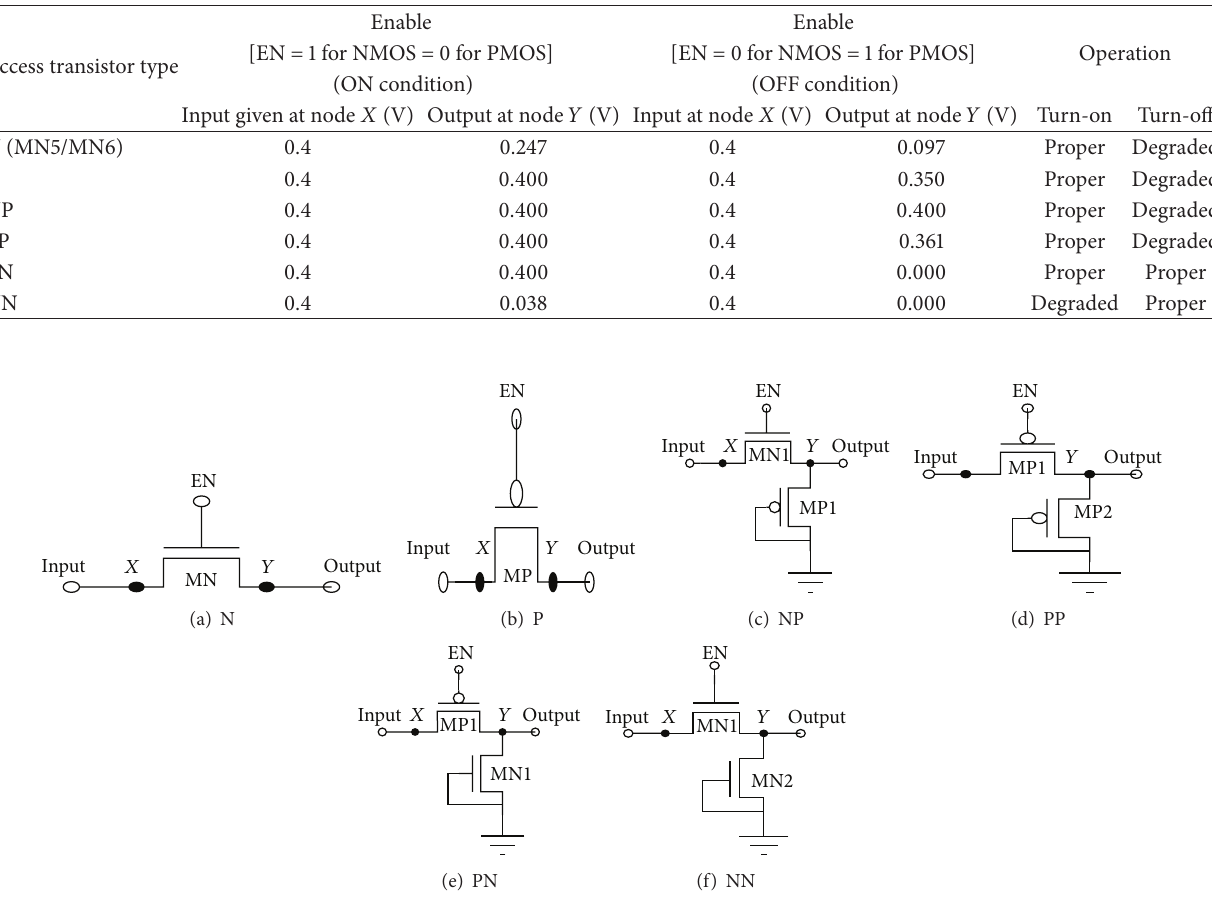
Table 1: Results of conventional and modified access transistors logic at 0.4 V supply in 45 nm technology.